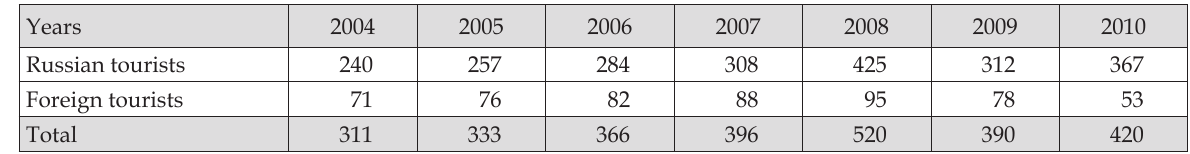
Table 4. Tourists in the Kaliningrad Oblast in the years